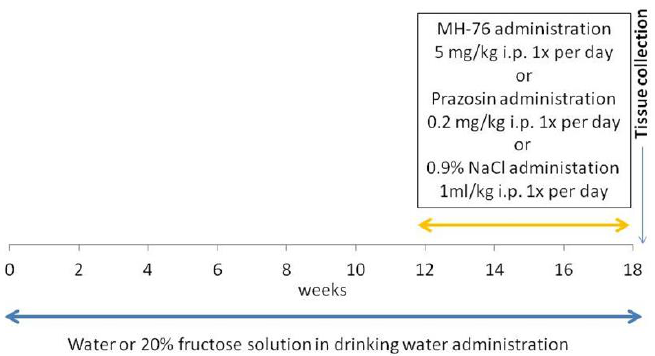
Figure 11. Timeline of the experiment.